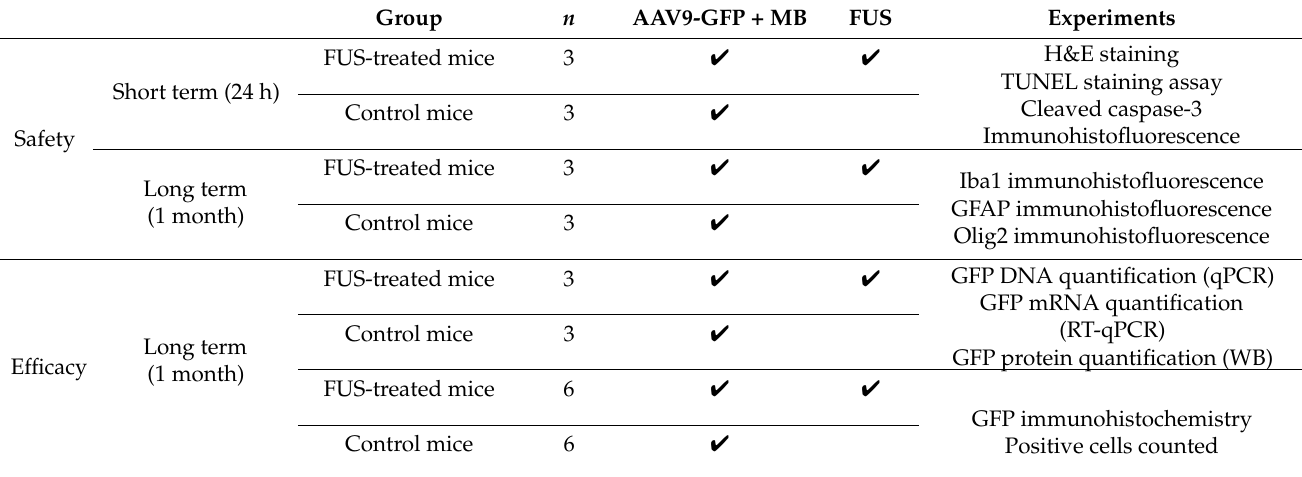
Table 1. Summary table of the number of animals studied per group, experimental conditions, latency between FUS-induced BBB disruption and the sacrifice of the animal, and experiments performed on their